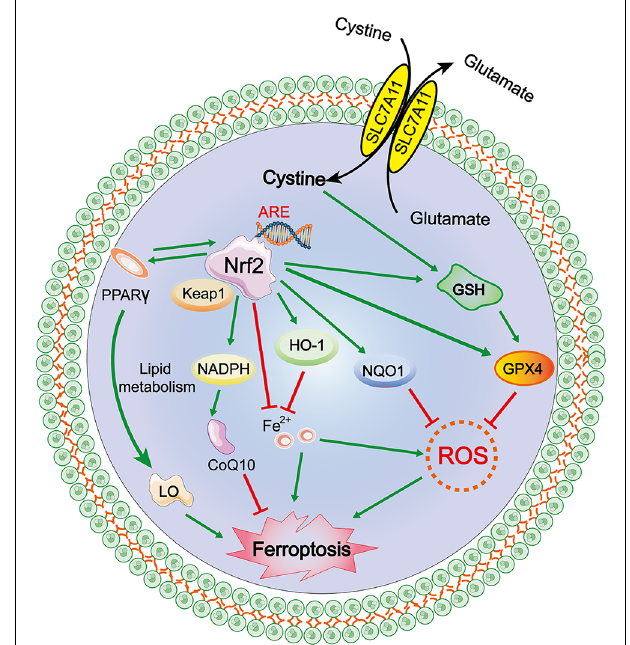
FIGURE 3 | Mechanism of ferroptosis, NRF2/antioxidant response element (ARE)–GPX4 pathway. known as SLC7A11 or system Xc − ) and amplifies